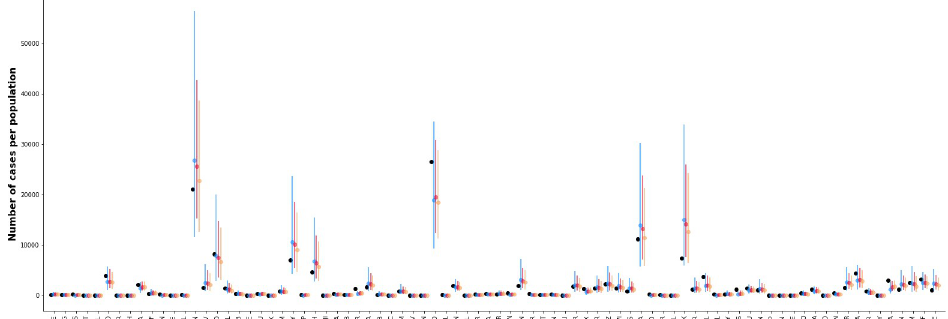
Fig 5. Estimated absolute numbers of early-onset invasive GBS disease cases (y-axis). Estimates for the 82 countries (x-axis) with maternal GBS colonization data are shown. Black circles represent the number of cases estimated in the evidence synthesis work by Seale and colleagues; uncertainty ranges reported by the authors are not Bayesian and not included in this figure. Estimates from different models described here correspond to different colours: blue represents Bayesian estimates that do not use incidence data; red represents full model I; and orange, full model II. For comparability, we used the same numbers of live births per country as Seale and colleagues. See also Fig J in S1 Appendix for a similar comparison on the incidence